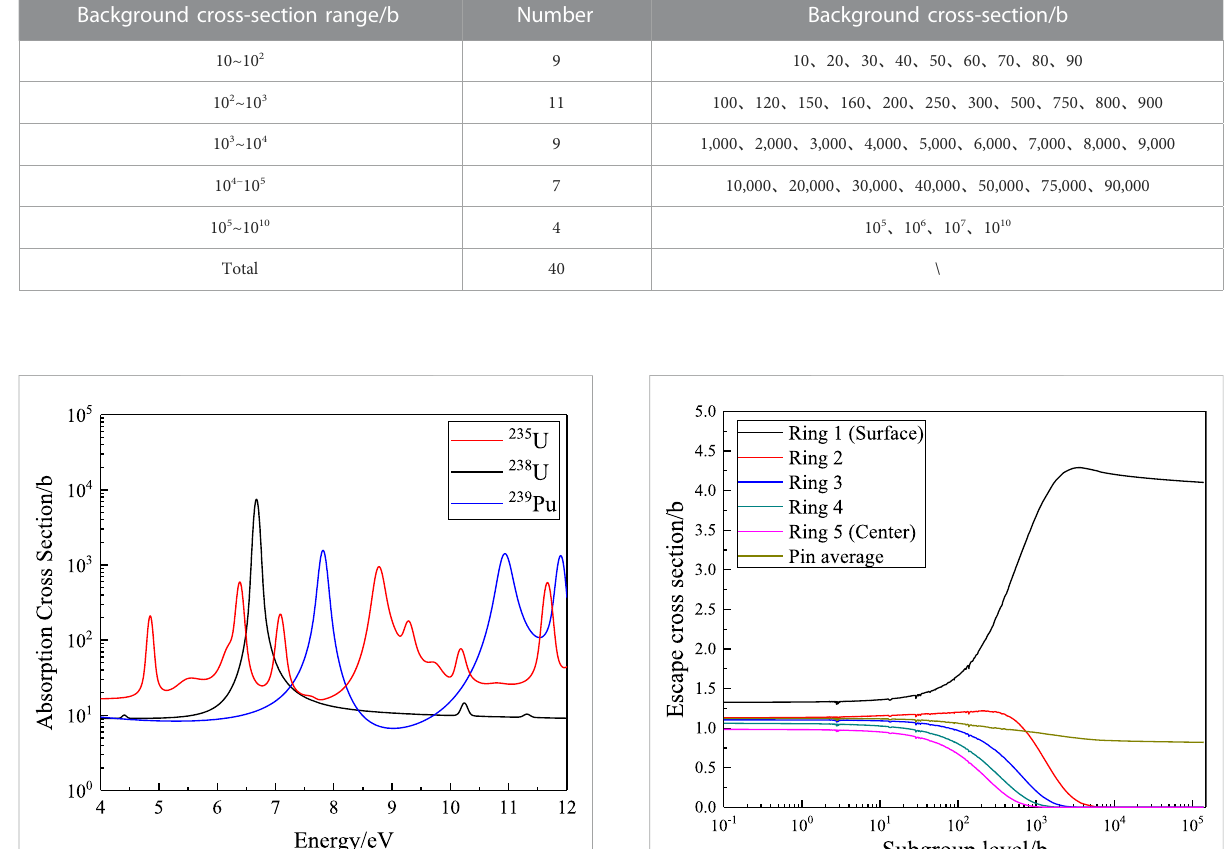
FIGURE 1 Variation curve of the absorption cross-section for 235 U, 238 U, and 239 Pu around 6.7 eV.